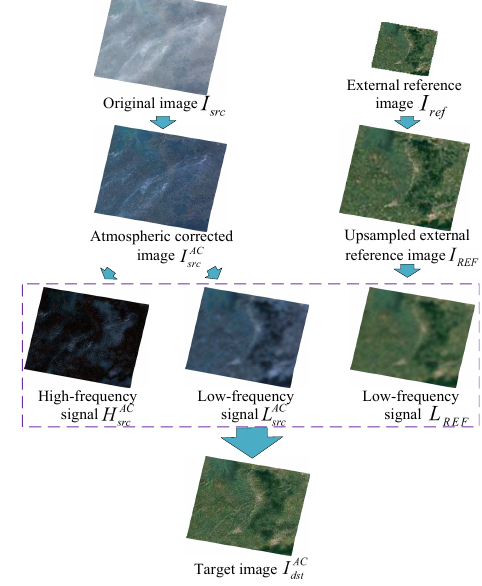
Figure 1. Flowchart of the proposed